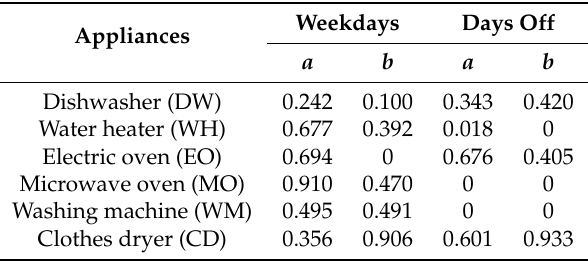
Table 3. Parameters a and b of QoE mapping functions for delay-tolerant appliances